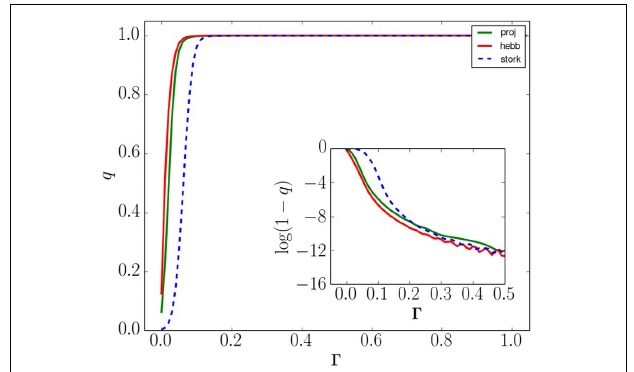
FIGURE 6 | Recall probability q with respect to applied bias (cid:3) for n = 4 neurons and p = 4 memories from the set in Equation (23). The Hebb rule is least sensitive to the applied bias, and nearly the same as the projection rule, while the Storkey rule becomes more sensitive to applied bias. Inset: a semi-log plot showing how recall error decreases with applied bias. Numerical noise dominates the inset plot beyond (cid:6) ≈ 0 . 3